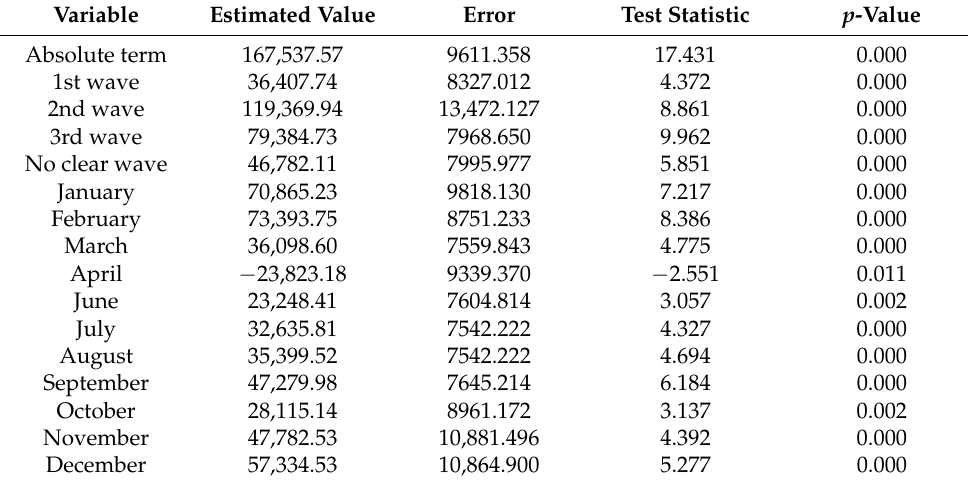
Table 4. Estimated values of the parameters of the regression